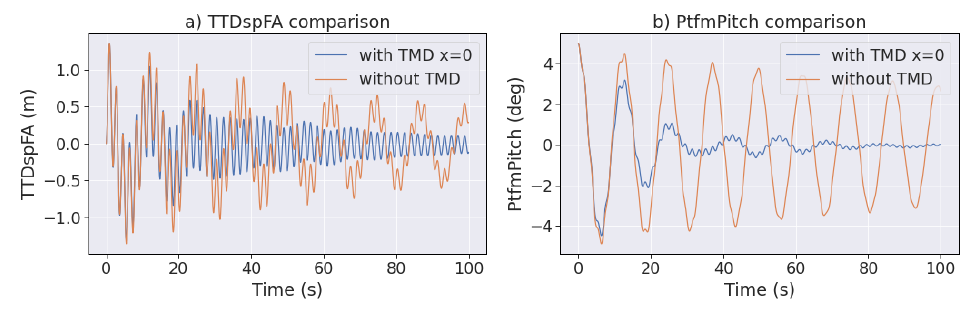
Figure 6. Comparison of the TTDspFA ( a ) and PtfmPitch ( b ) without TMD (orange) and with a TMD located under the tower